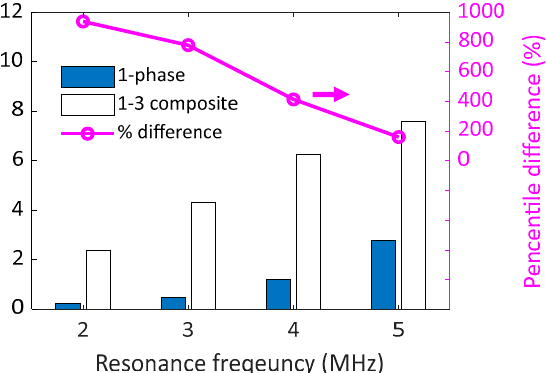
Figure 7. Comparison of acoustic pressure outputs in the single-phase and the 1–3 composite transducers at selected frequency conditions.